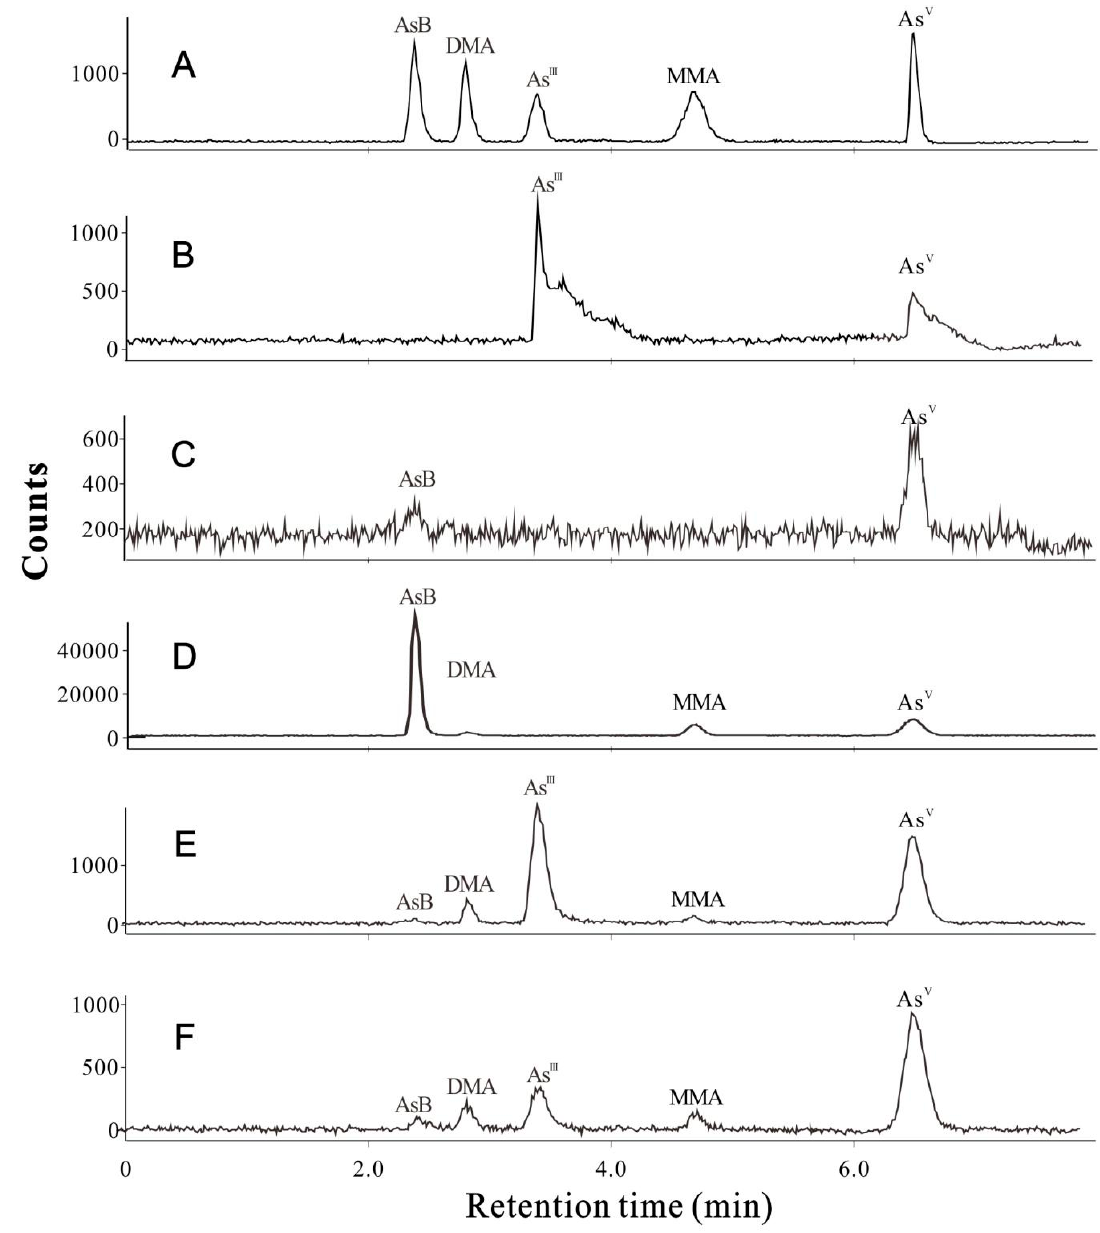
Figure 2. Total ion currents of As species in the standards ( A ), COS ( B ), CM ( C ), AB ( D ), LE ( E ), and AA ( F ).